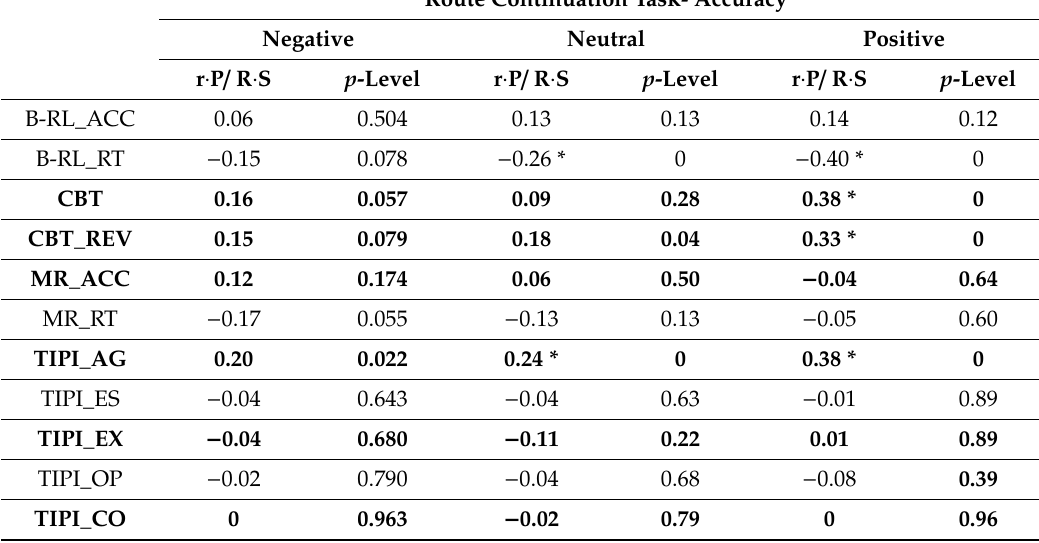
tasks, personality traits, and accuracy at the route continuation task. Pearson correlations (r · P) are reported in bold. The Spearman correlations (R · S) are not in bold. The asterisk (*) indicates the correlations that survived to the correction for multiple